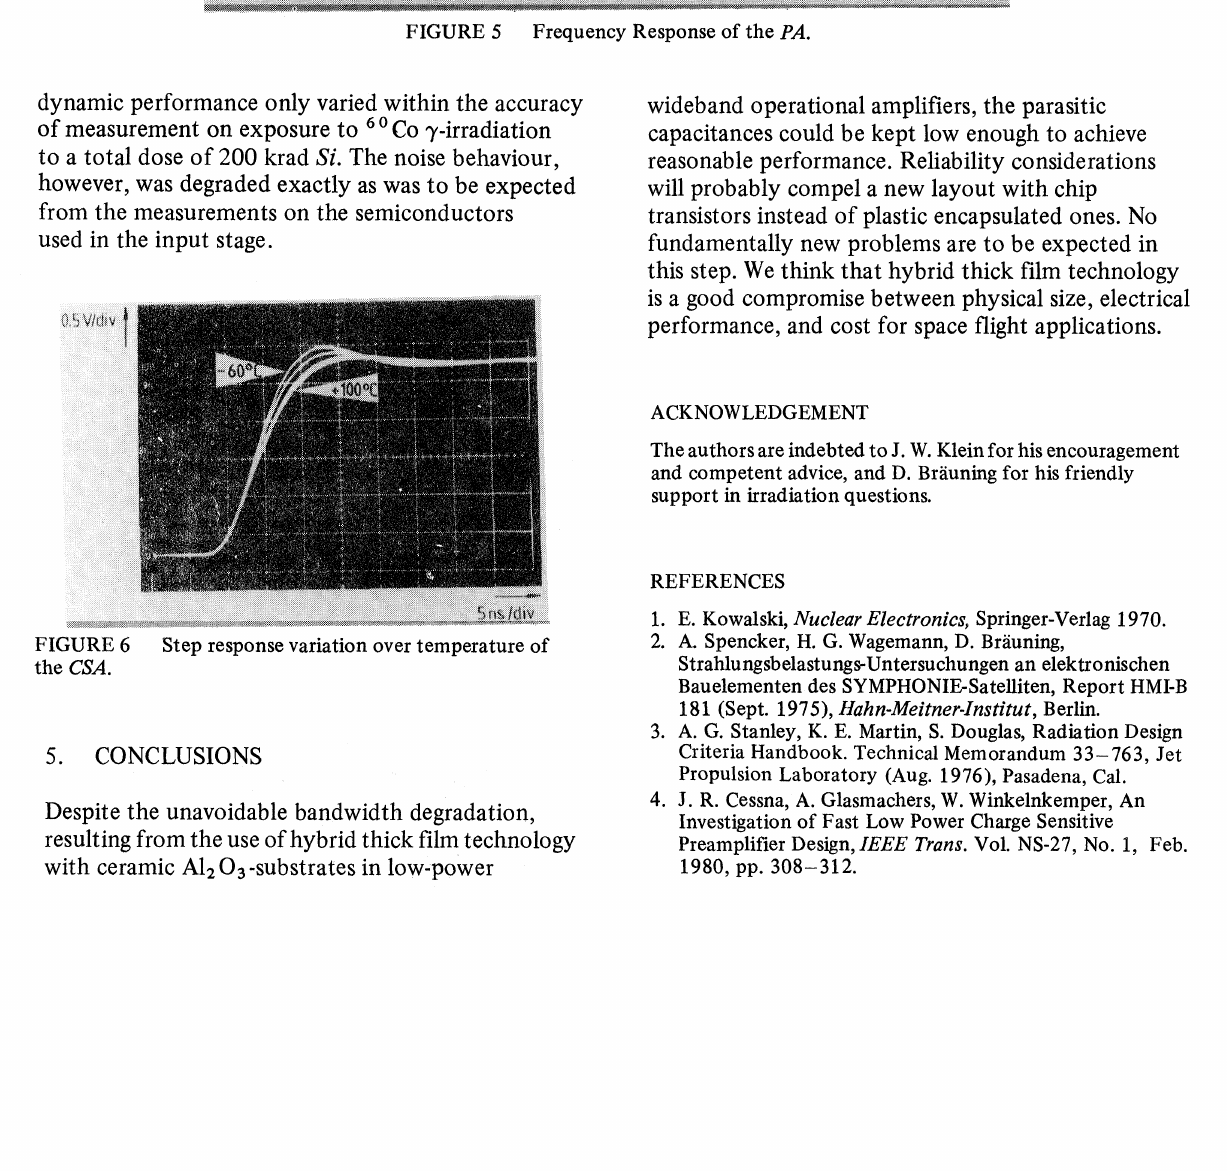
FIGURE 5 Frequency Response of the PA.